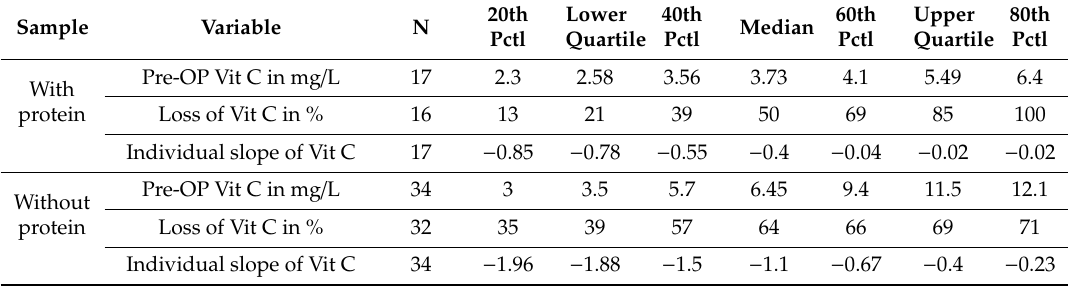
Table 2. Description of perioperative values of vitamin C with di ff erent probe treatments. Vit,